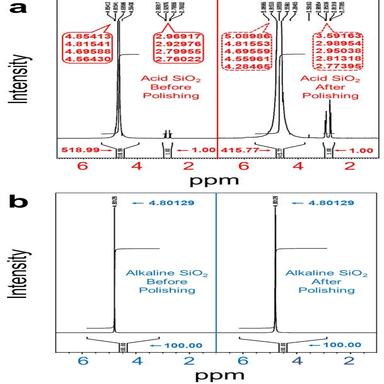
Comparison of nuclear magnetic resonance spectra on (a) acid and (b) alkaline SiO2 abrasives before and after 6 h polishing.